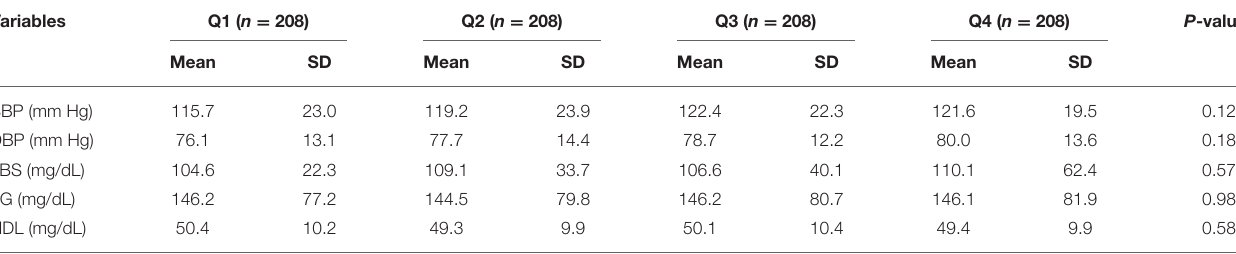
TABLE 2 | Cardiometabolic profile of the study participants across quartile of the DLIS in Tehranian adults.